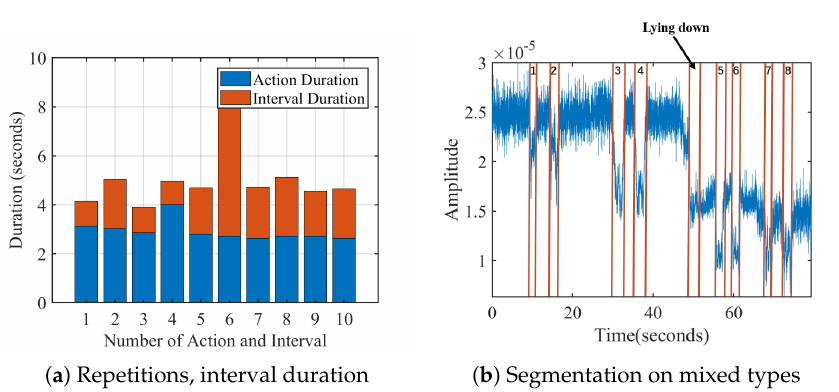
Figure 12. Repetition analysis results of MobiFit